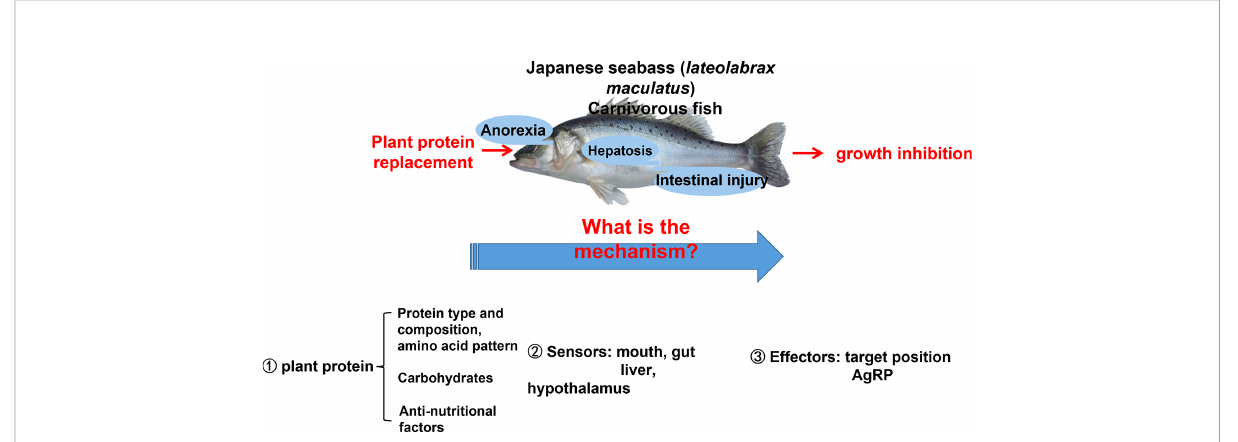
FIGURE 6 Research on the AgRP neuropeptide and its glucose sensor function will help to solve the ef fi cient utilization of high-plant protein feed problems in carnivorous fi sh, thus promoting the development of aquaculture and the fi sh feed industry. This research clari fi es the mechanisms underlying anorexia and metabolic disorders in carnivorous fi sh that affect their growth